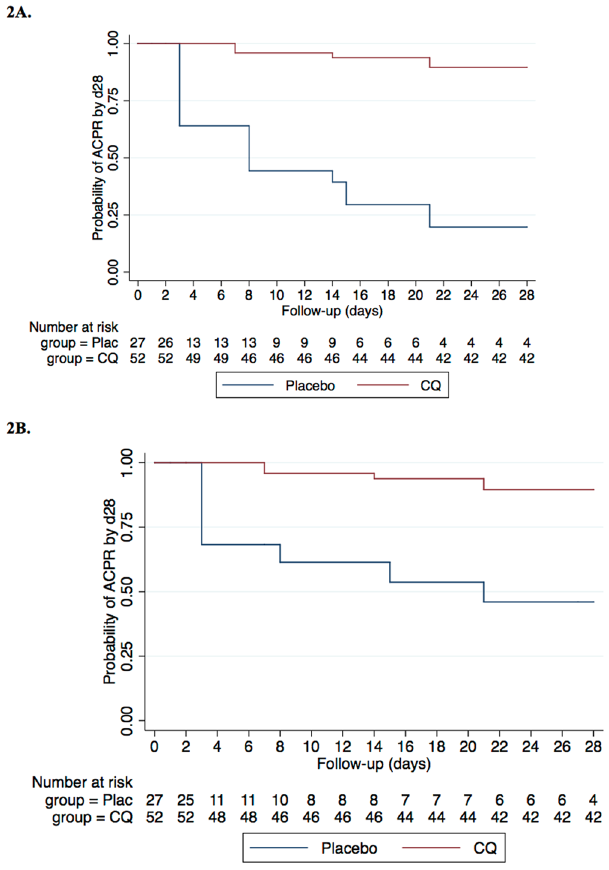
Figure 2. PCR uncorrected ( 2A ) and PCR-corrected ( 2B ) Kaplan Meier curves showing the treatment success cumulative proportion for each study arm until day 28 in the ATP population. Cumulative risks of failure were computed for day 28 and Log-Rank tests used to compare the number of events that occurred in each arm. PCR-corrected curves censored participants who experienced a reinfection on the day it was